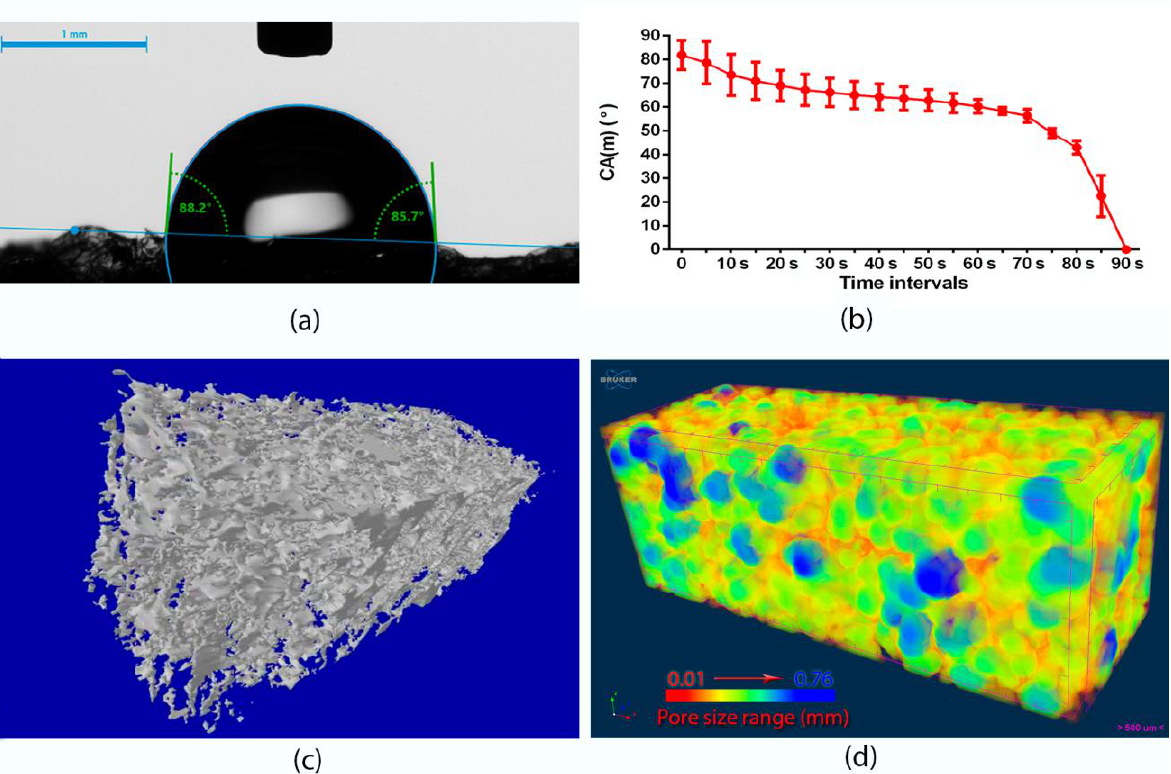
Figure 3. Wettability and porosity tests results: ( a ) Goniometer image presenting a contact angle of an ultrapure water droplet formed on the top surface of CHN/A biomaterial; ( b ) Graph showing static water contact angle measurements over time; ( c ) Three-dimensional model of porous biomaterial structure obtained with microCT; ( d ) MicroCT image presenting color-coded pore size distribution (from 0.01 to 0.76